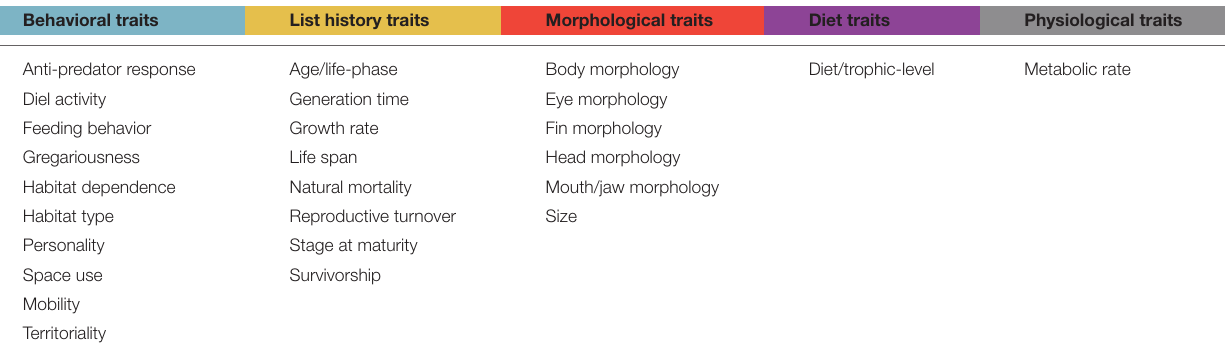
TABLE 1 | Broad groupings of traits, where blue corresponds to behavioral traits, yellow to life-history traits, red to morphological traits, purple to diet traits, and gray to physiological